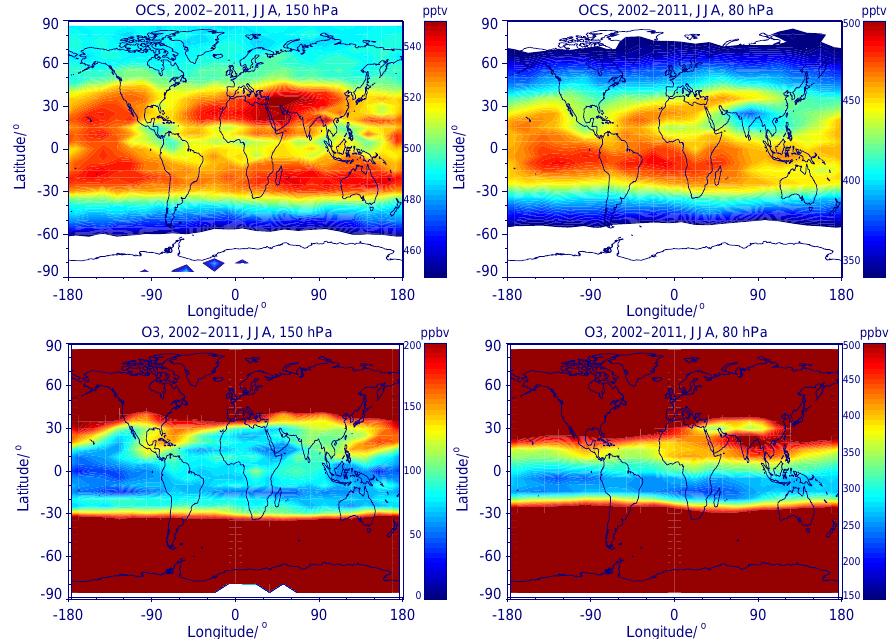
Figure 12. Top row: OCS distribution measured by MIPAS between June and August 2002–2011 at the 150hPa (left) and at the 80hPa level (right). Bottom row: same as top row, but for MIPAS O 3 .